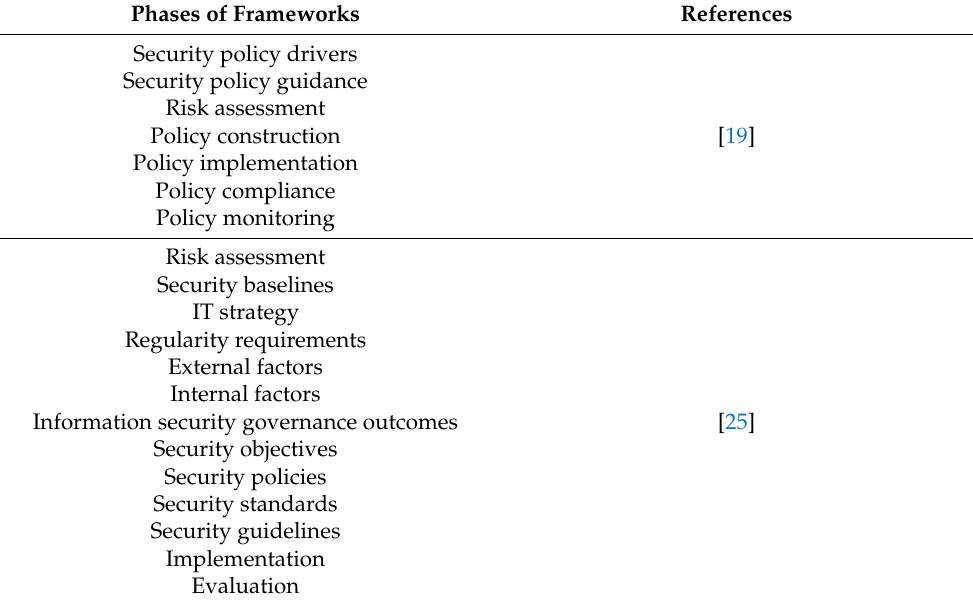
Table 1. Existing